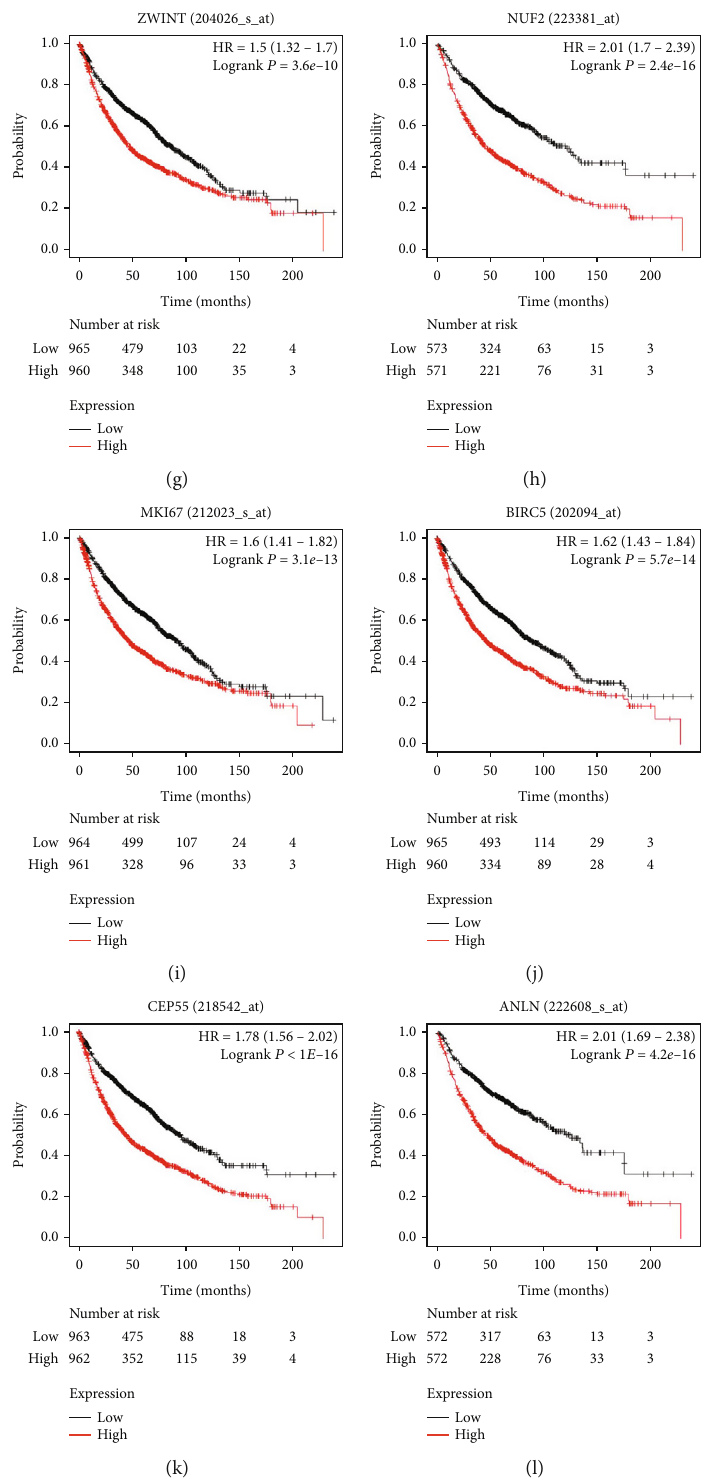
Figure 5: Overall survival analyses of 12 hub genes were performed using the Kaplan-Meier plotter online platform. P < 0 : 05 was considered statistically signi fi